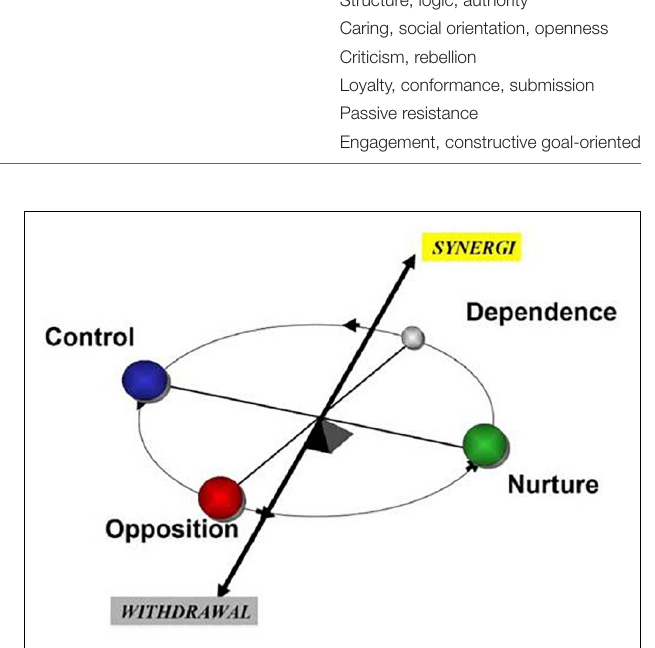
FIGURE 1 | The SPGR instrument relies on a factor analytical model consisting of these basic